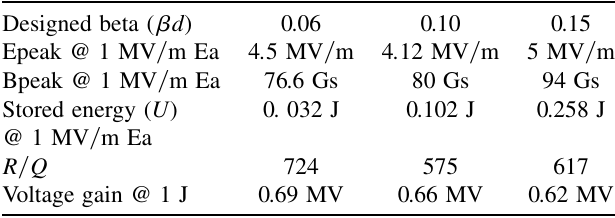
TABLE II. Design parameters of QWR simulated by CST